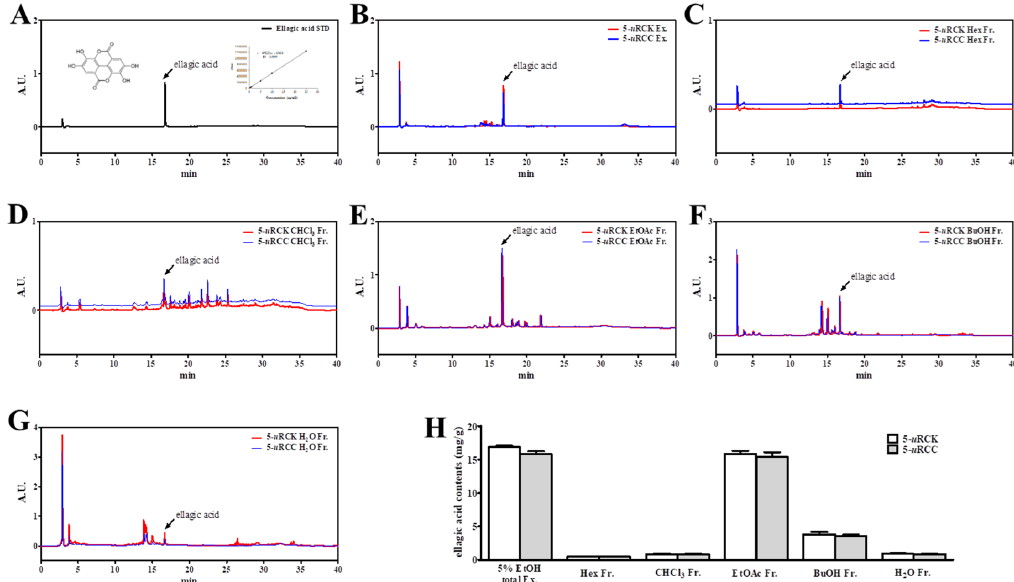
Figure 2. HPLC-diode array detector (HPLC-DAD) chromatograms of the major components of 5- u RCK or 5- u RCC and their fractions. The peak with a retention time of 16.5 min was assigned to ellagic acid. Ellagic acid was identified at a wavelength of 254 nm. Chromatograms of standard ellagic acid ( A ), 5% ethanol extracts of u RCK or u RCC ( B ), n -hexane fractions of 5- u RCK or 5- u RCC ( C ), chloroform fractions of 5- u RCK or 5- u RCC ( D ), ethyl acetate fractions of 5- u RCK or 5- uRCC ( E ), n -butanol fractions of 5- u RCK or 5- u RCC ( F ), and water fractions of 5- u RCK or 5- u RCC ( G ). ( H ) The amount of ellagic acid in the extracts and fractions of 5- u RCK or 5- u RCC. The data are represented as the means ± SDs.